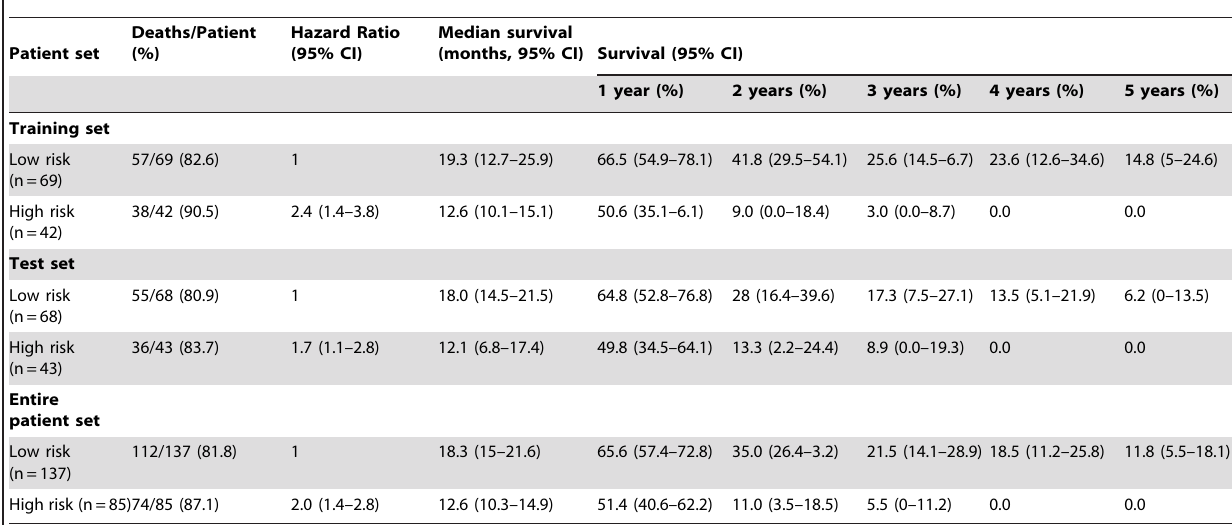
Table 3. Kaplan Meier overall survival analysis in the training set, the testing set and the entire patient set.